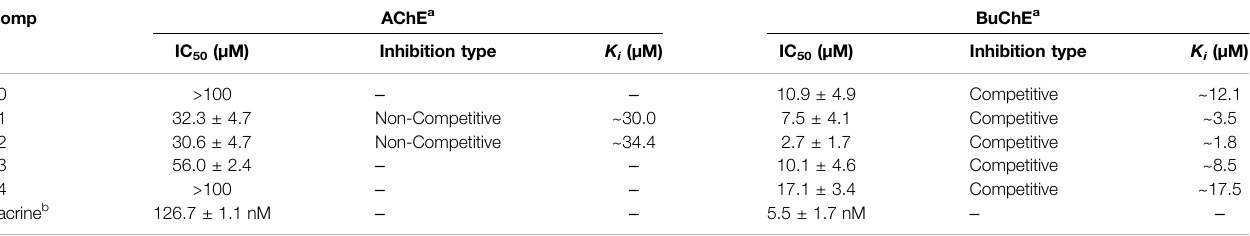
TABLE 1 | Inhibitory activity of compounds 30 – 34 against AChE and BuChE.